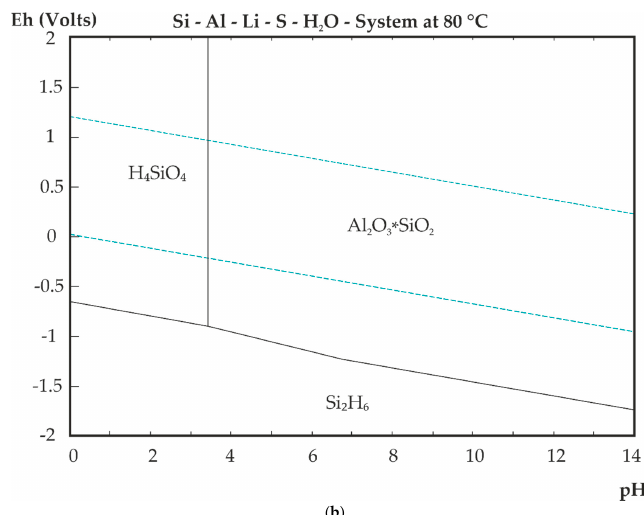
Figure 6. Eh-pH diagram for Si-Al-Li-S-H 2 O system: ( a ) 20 °C, ( b ) 80 °C. Molarity: (Li) = 1 M, (Al) = 0.5 M, (S) = 0.5 M and (Si) = 0.05